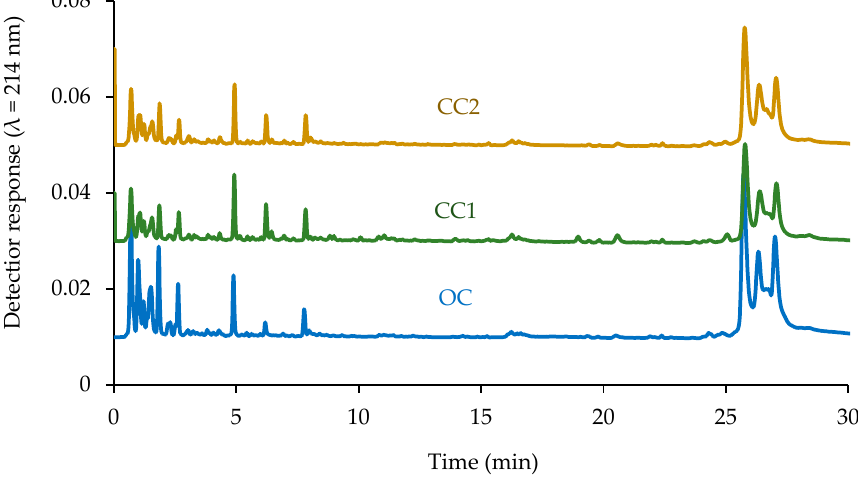
Figure 2. Reverse-phase ultrahigh-performance liquid chromatography (RP-UPLC) profiles of protein isolates from an organically (OC) and two conventionally (CC1 and CC2) cultivated hempseeds.